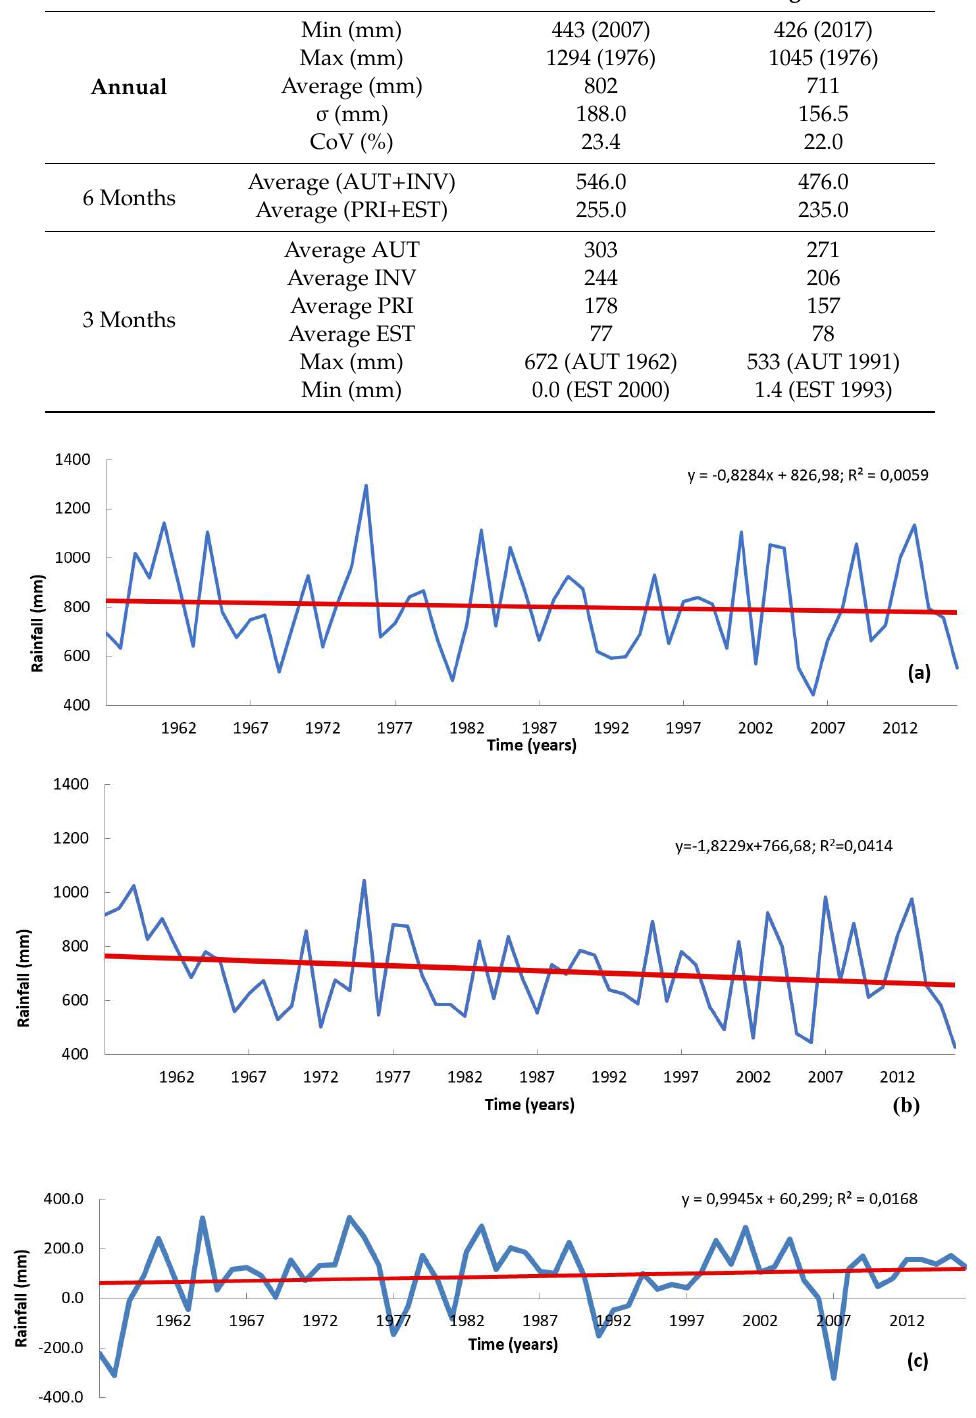
Figure 2. Annual rainfall in Casalotti ( a ) and Collegio Romano ( b ) and absolute difference (mm) between Casalotti and Collegio Romano ( c ) by year, 1958–2017.